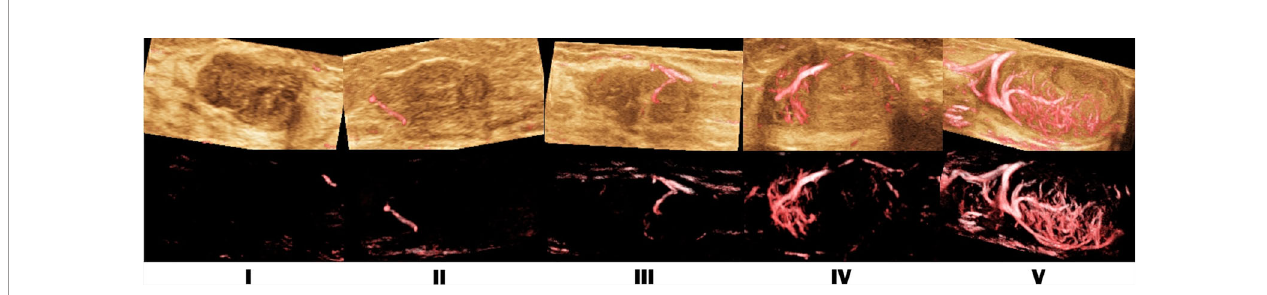
FIGURE 2 | SMI vascular architecture (VA) types. I. no vascular pattern; II. dotted and linear pattern; III. tree-like pattern; IV. residual root-like pattern; V. crab claw- like pattern.